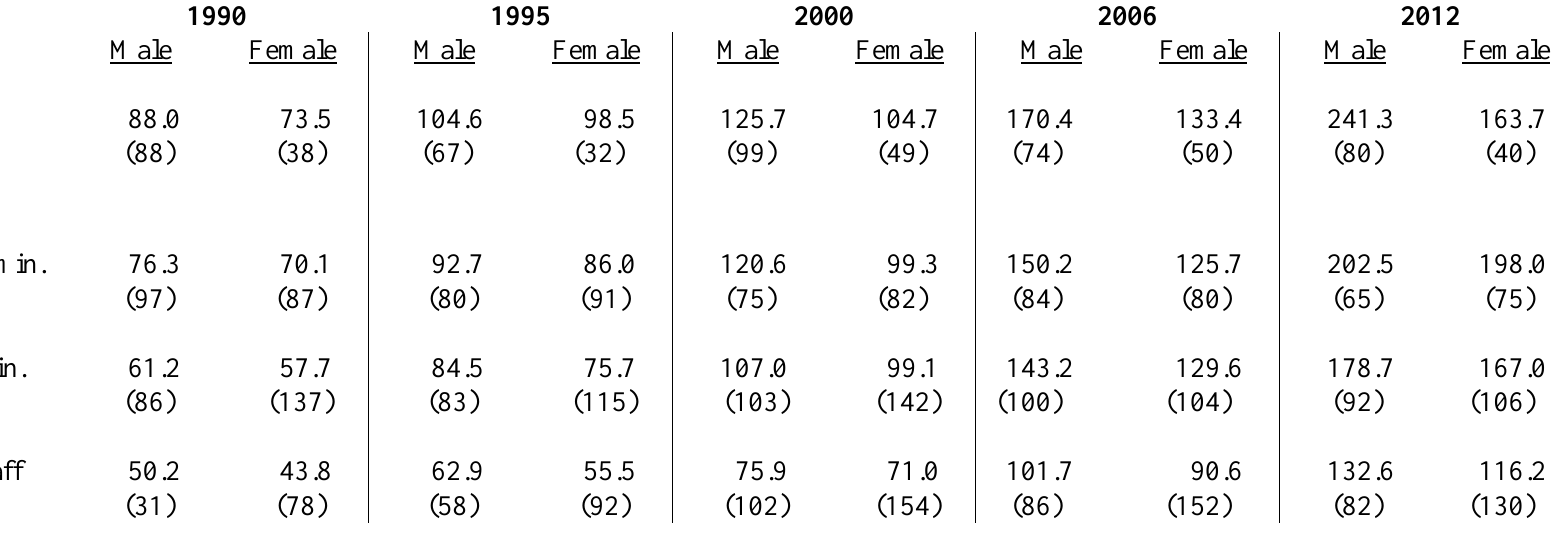
Table 8. Median Salary by Position (Full-time only)